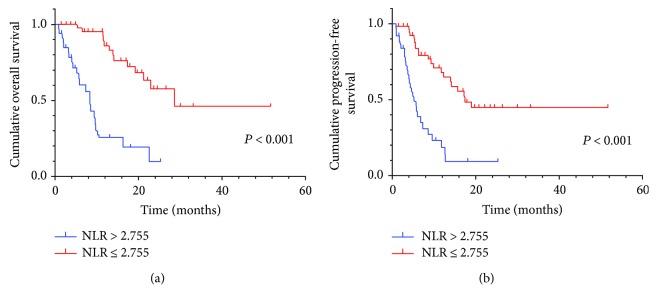
(a) Kaplan–Meier curve for OS of 103 GC patients stratified by NLR. Median OS is 5.8 (95% CI: 5.2–9.4) and 13.0 (95% CI: 12.2–17.7) for NLR > 2.755 and NLR ≤ 2.755, respectively. (b) Kaplan–Meier curve for PFS of 103 GC patients stratified by NLR. Median PFS is 4.7 (95% CI: 4.3–7.5) and 8.9 (95% CI: 9.7–14.8) for NLR > 2.755 and NLR ≤ 2.755, respectively.